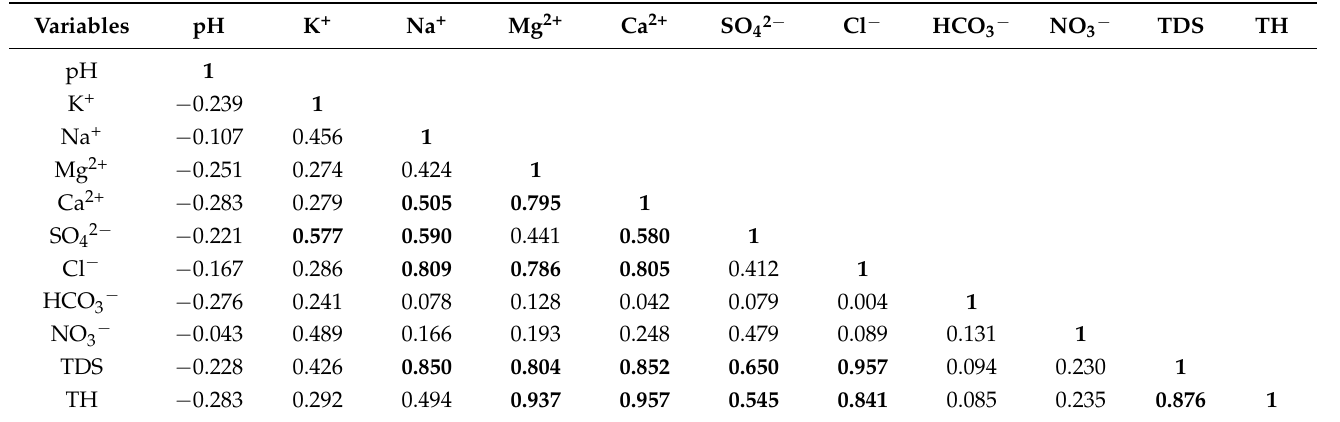
Table 4. Correlation matrix (r) of studied physico-chemical